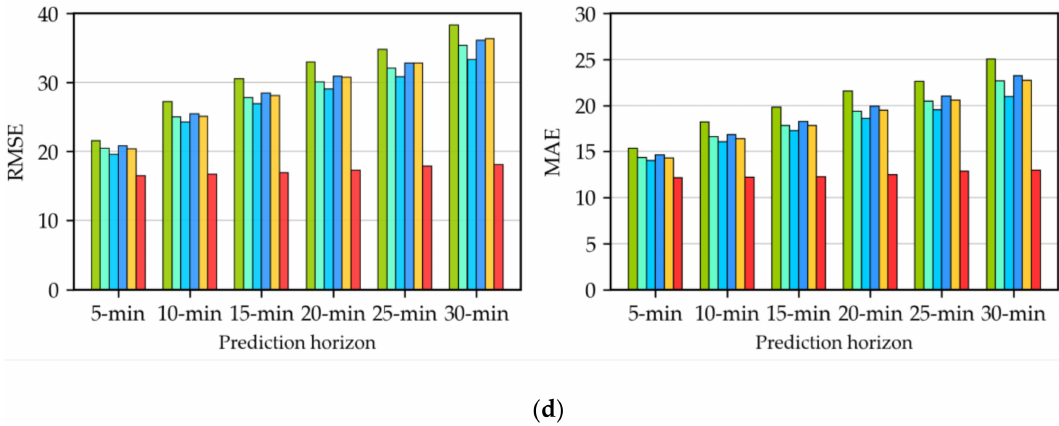
Figure 9. Evaluation of the multistep predictions: ( a ) exit passenger flow of the Q.R. Sta., ( b ) entrance passenger flow of the Q.R. Sta., ( c ) exit passenger flow of the J. Sta., and ( d ) entrance passenger flow of the J. Sta. Table 4. Diebold–Mariano (DM) test results of the comparison between the proposed SSA-AWELM and benchmarks.